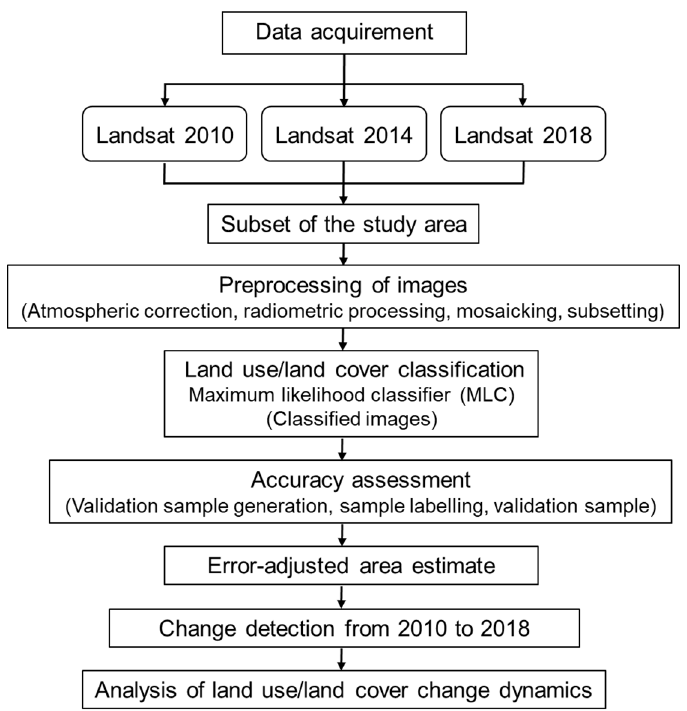
Figure 3. Methodology flowchart performed in the study.